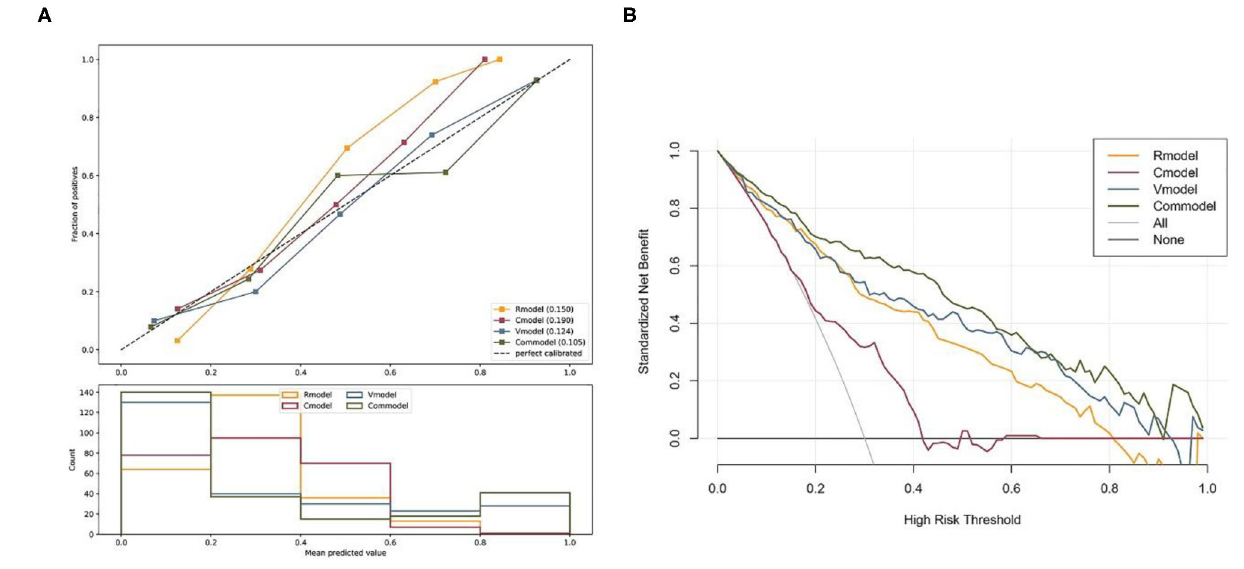
FIGURE 6 | (A) Calibration curves of the Rmodel, Cmodel, Vmodel, and Commodel. (B) The decision curve analysis for the Rmodel, Cmodel, Vmodel, and Commodel. The decision curve analysis showed that the Commodel had the highest overall net benefit ratio compared with the Rmodel, Cmodel, and Vmodel. Rmodel , radiomics signature model; Cmodel , clinical model; Vmodel , the model based on volume values; Commodel , the model combined with both radiomic features and volume